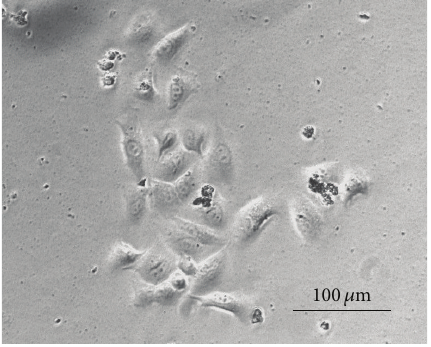
Figure 1: Microscopic image of the monolayer culture of NCI-H460 cells in 5% RPMI1640 after 24 hours incubation in 6-well plates.